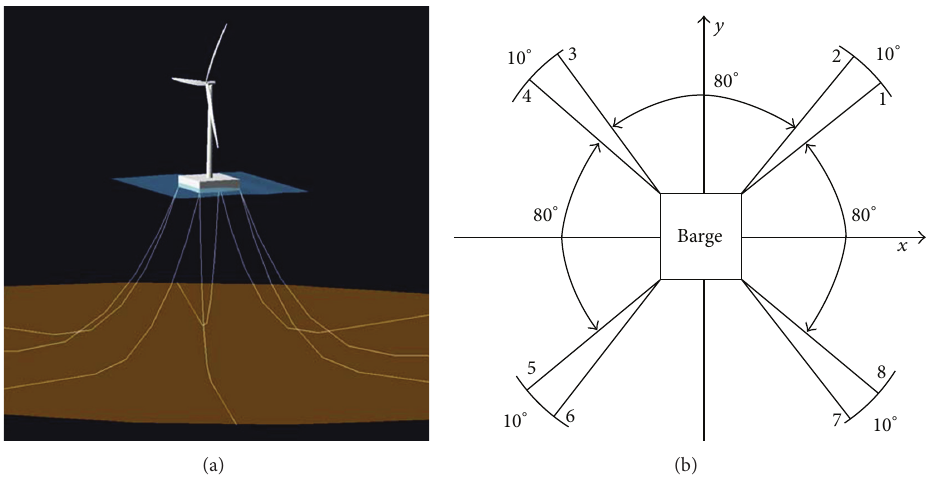
Figure 5: Mooring system configuration of FWT. (a) ITI Energy barge. (b) Mooring system layout.